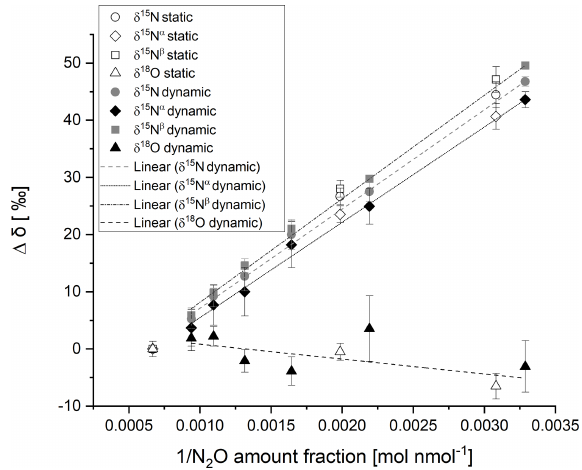
Figure 2. CRDS analyser response for δ 15 N (circles), δ 15 N α (dia- monds), δ 15 N β (squares) and δ 18 O (triangles) with the reciprocal of N 2 O amount fraction for static (open data labels) and dynamic (filled data labels) reference materials in the amount fraction range of 300–1500nmolmol − 1 . Error bars represent the repeatability in per mille between the four repetitions of a 5min average. The dot- ted and dashed lines represent the linear regression of dynamic ref- erence materials for each